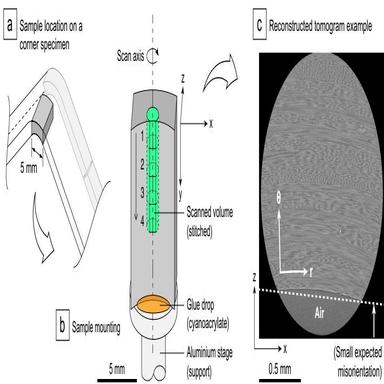
Schematics of the corner-only sample preparation for X-μCT scanning: (a) sample location relative to the corner specimen geometry; (b) sample mounting on X-μCT aluminium stage; (c) reconstructed tomogram example.